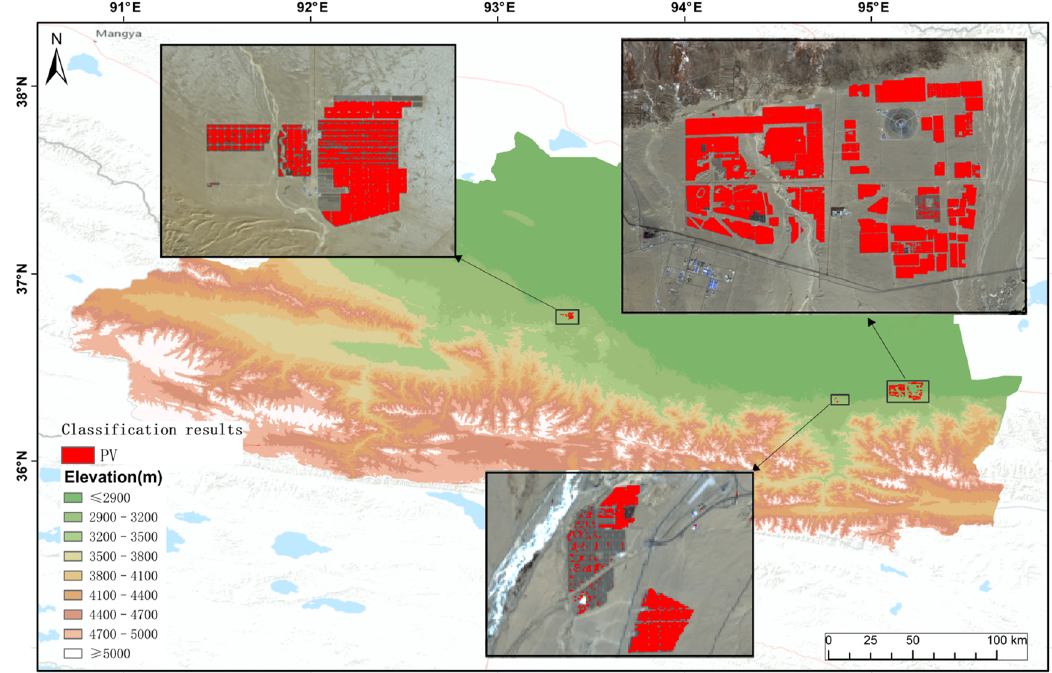
Figure 10. Illustration of the PV plants extraction results using the XGBoost model based on Plan 3.